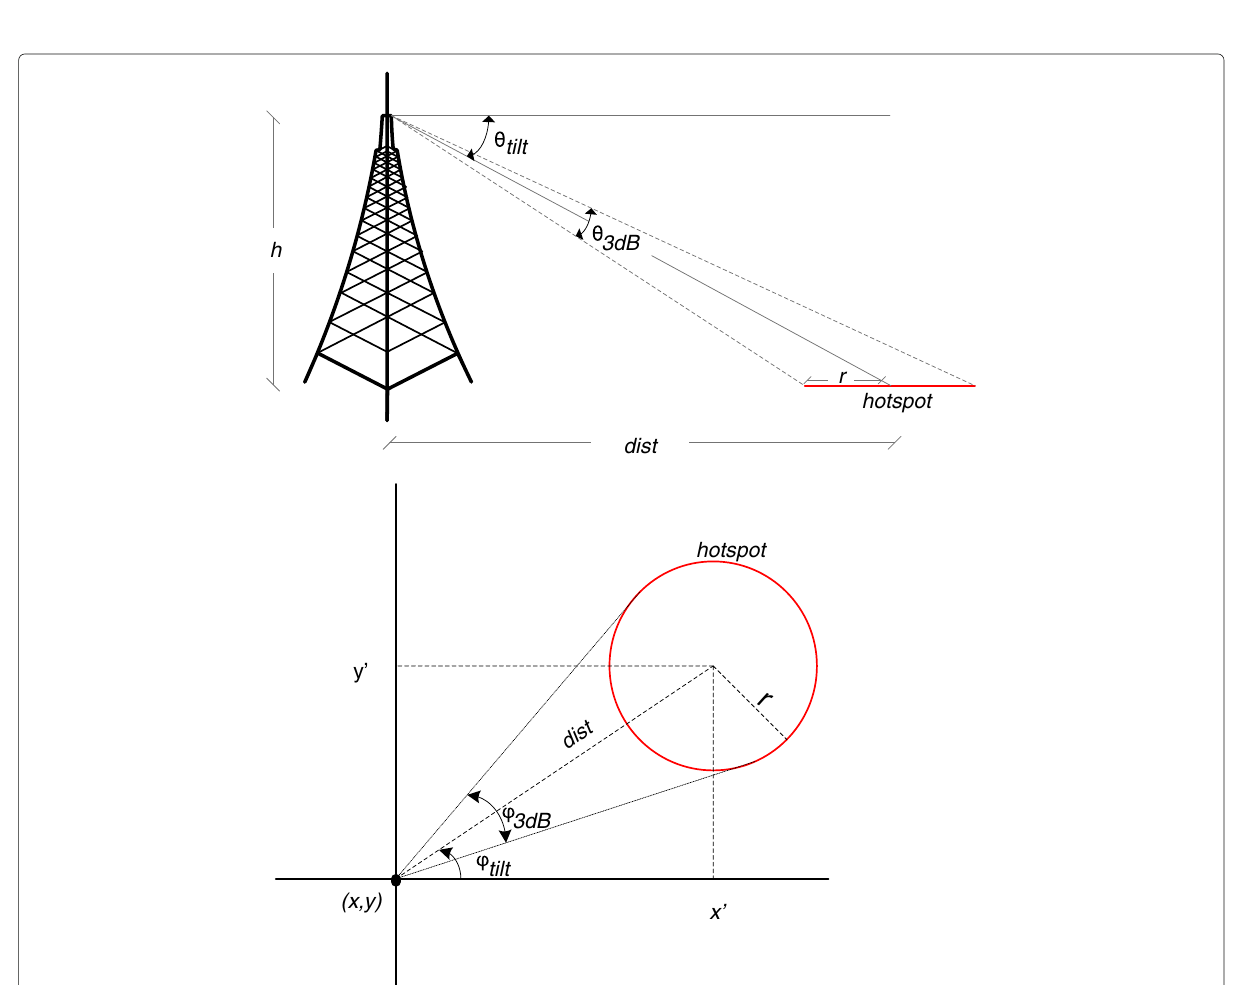
Fig. 2 Beamwidth and beam steering in the vertical and horizontal planes. This figure represents the architecture of a BS with the angles in the horizontal and vertical planes that are used for building this VSC. Figure 2a represents the angles of the beam in the vertical plane. And Fig. 2b represents the angles of the beam in the horizontal